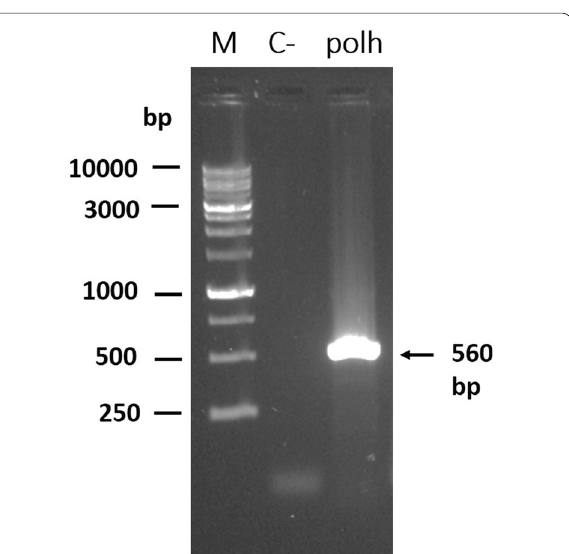
Fig. 4 Partial amplification of polyhedrin gene ( polh ) by PCR using gene-specific primers. Polh: Represent PCR amplicon of polyhedrin gene (partial). C-: Negative control in which DNA was omitted. M represents 1 kb DNA